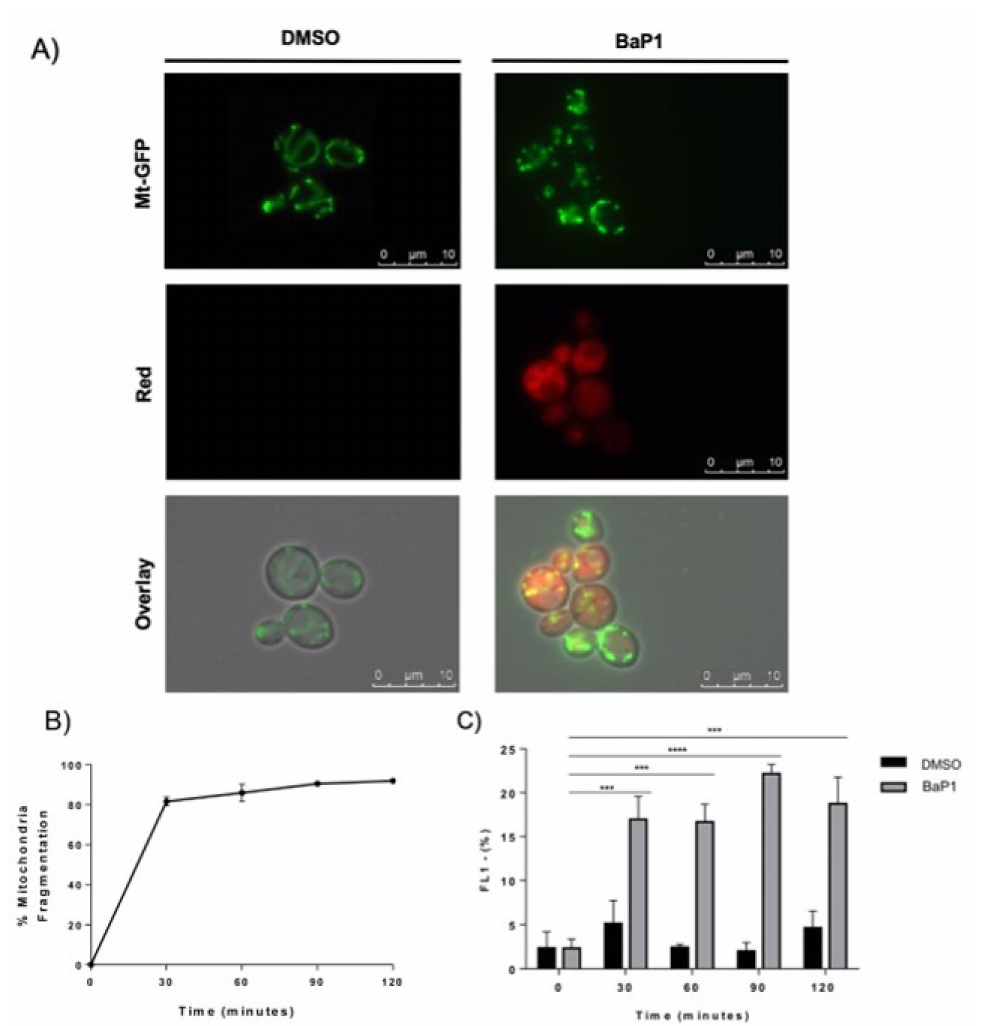
Figure 3. Evaluation of mitochondrial morphology and mitochondrial membrane potential. ( A ) Fluorescence microscopy images of W303-1A pYX-mt-GFP cells after 30 min of treatment with BaP1 (300 µ M) or DMSO (negative control). Samples were collected at different time points, before (time 0) and after 30, 60, 90, and 120 min of treatment, and then visualized by epifluorescence microscopy with a 100 × oil immersion objective; ( B ) percentage of BaP1-treated cells displaying mitochondrial network fragmentation. At least 300 cells were counted for each condition. ( C ) Effect of BaP1 on mitochondrial membrane potential. Quantification of FL1 negative population (FL1 LOG) corresponding to the percentage of cells with mitochondrial depolarization. Values are the means with SD ( n ≥ 2). Statistical analysis was performed by two-way ANOVA. ns: non-significant, *** p < 0.001, **** p <